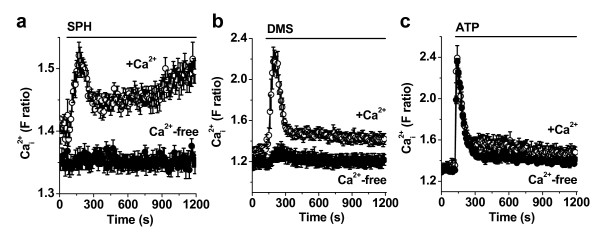
Sphingosine-evoked Ca2+ signals in HIG-82 cells. Data were generated by intracellular Ca2+ measurement. Responses elicited by (a) sphingosine (SPH, 20 μM), (b) dimethylsphingosine (DMS, 20 μM) or (c) adenosine triphosphate (ATP, 100 μM) were tested in either 1.5 mM Ca2+-containing (+Ca2+) or Ca2+-free extracellular solution. Responses are each representative of 3 (n) independent experiments.